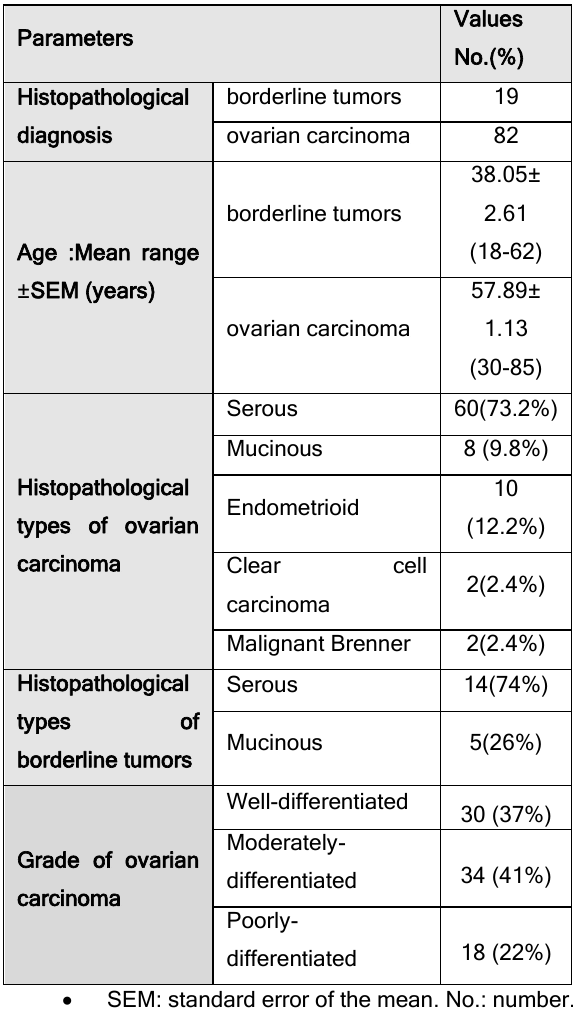
Table 1: clinicopathological parameters of borderline tumors and invasive ovarian carcinoma